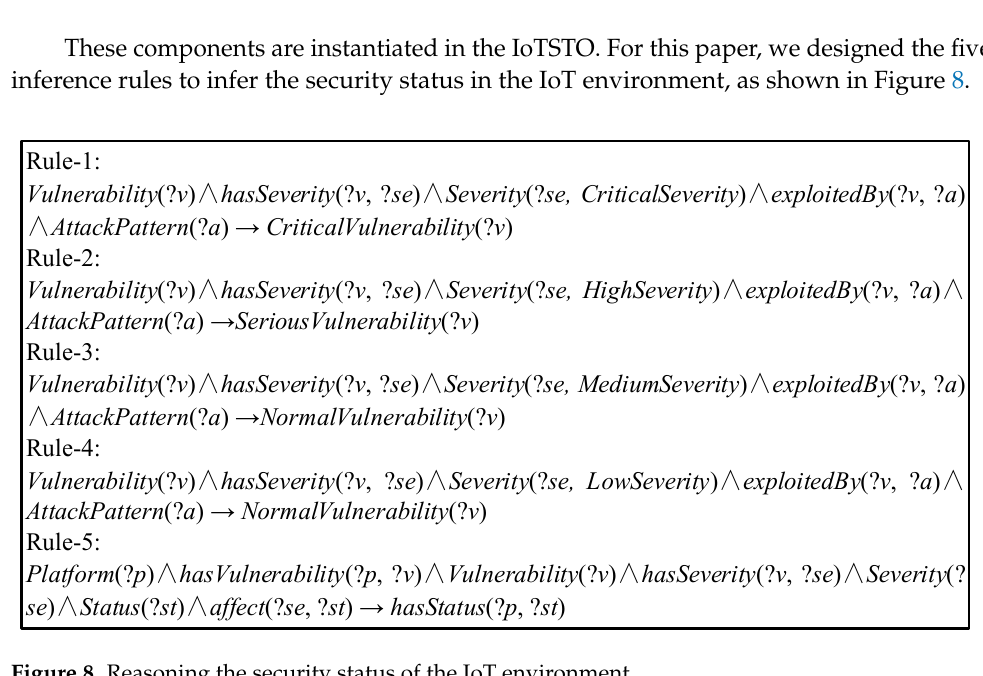
Figure 8. Reasoning the security status of the IoT environment.